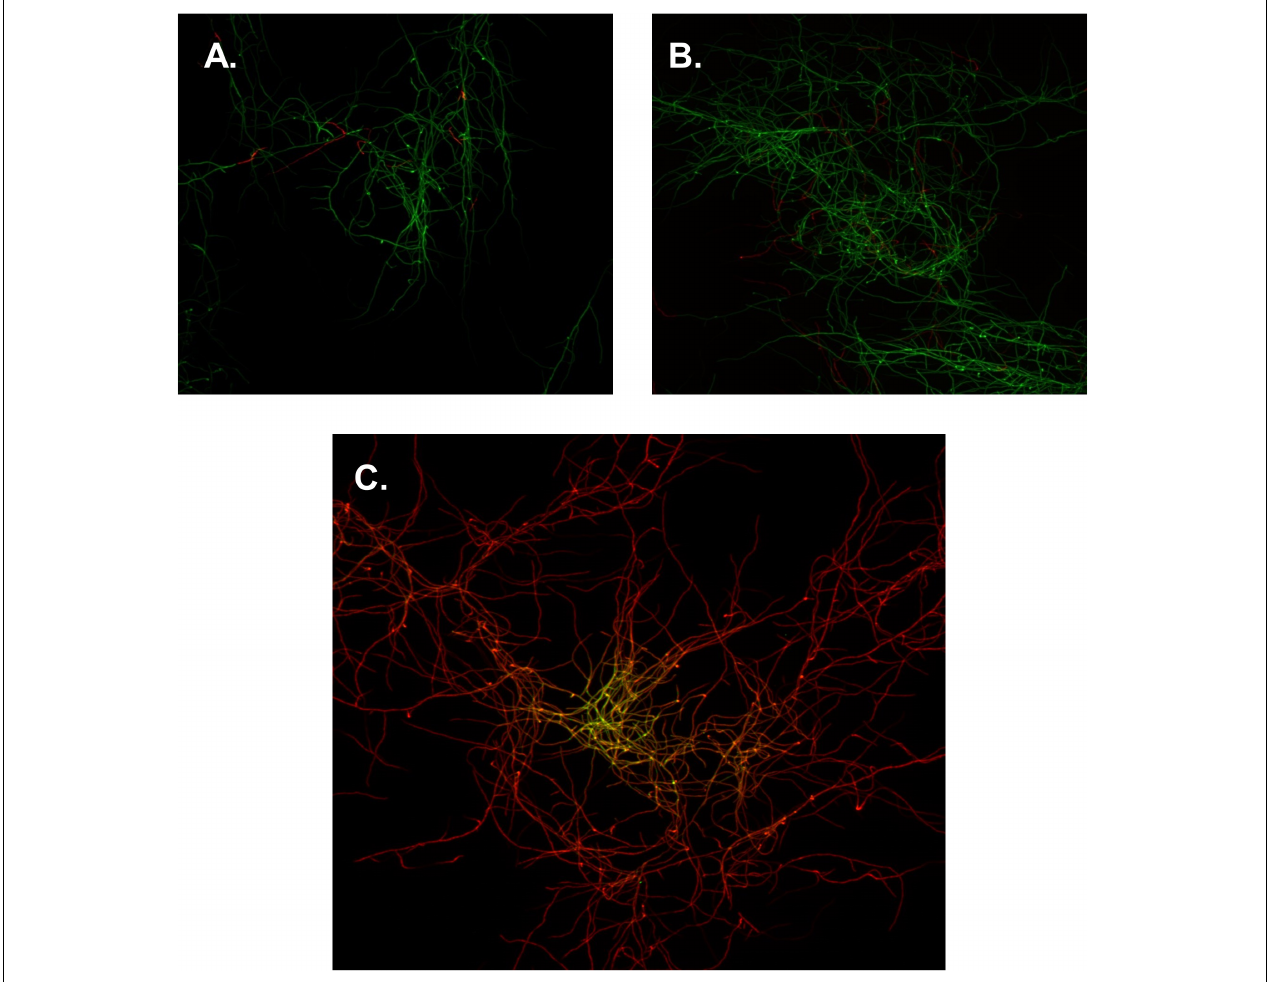
FIGURE 4 | Confocal microscopy images of S. scabies. (A) S. scabies positive control, incubated in 0.85% NaCl. (B) S. scabies DMSO control, incubated in 0.85% NaCl and 1% DMSO. (C) S. scabies treatment, incubated in 0.85% NaCl, 100 µ M SG, and 1% DMSO. Green cells represent staining with SYTO 9 and red cells represent staining with PI. Images were taken with a 40 × objective lens. Each image is 22 µ m × 22 µ m.